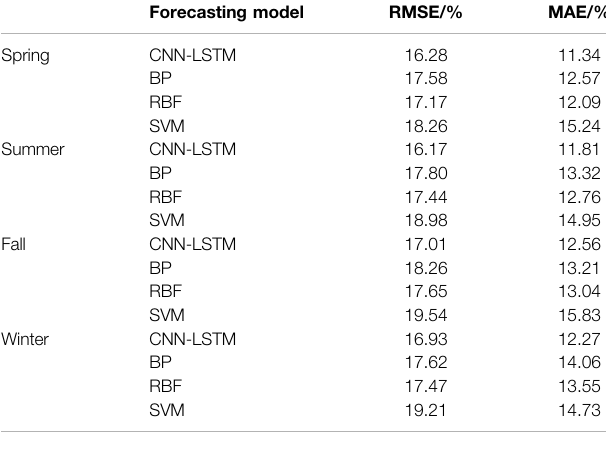
TABLE 4 | Comparison of evaluation indexes of the prediction model. Forecasting model